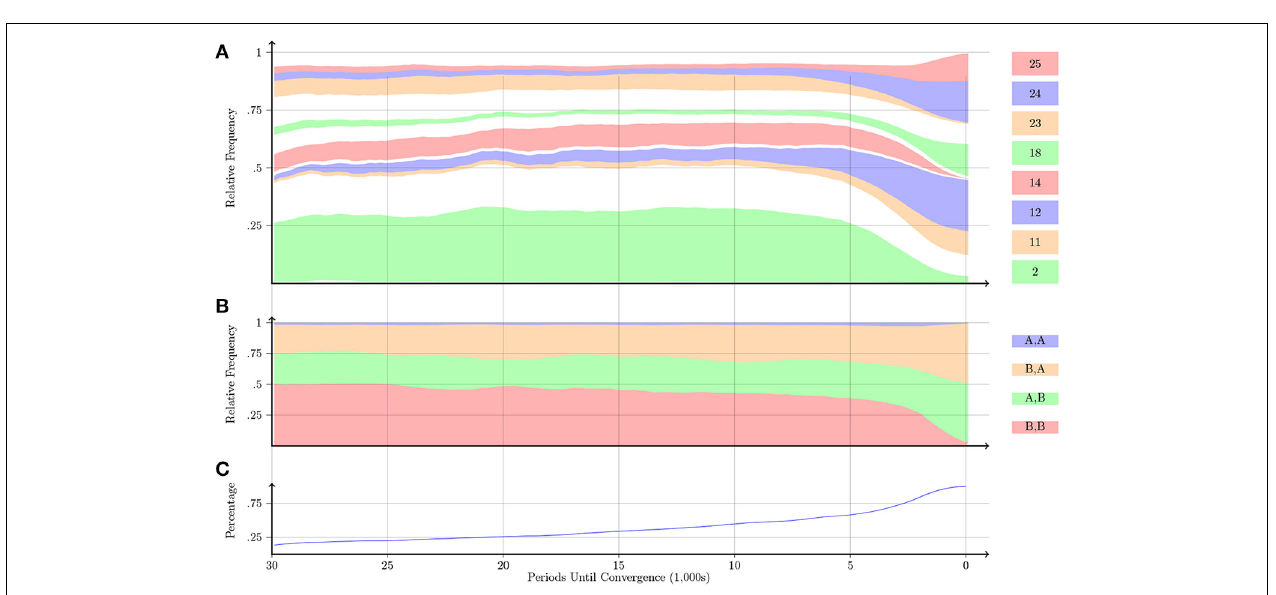
relative frequency of at least 10% in the 30,000 periods before convergence; the remaining automata are represented by the white regions. (B) Shows the progression of play of each of the four action profiles. (C) Displays the percentage of pairs that took longer than the given x-value to converge. For example, we observe in (C) that roughly 25% of the pairs took more than 20,000 periods to converge (and 75% of the pairs took less than 20,000 periods to converge). Thus, the corresponding x-values in (A) and (B) only reflect 25% of the pairs. All plots are smoothed by taking the average over the previous 2000 periods of play.